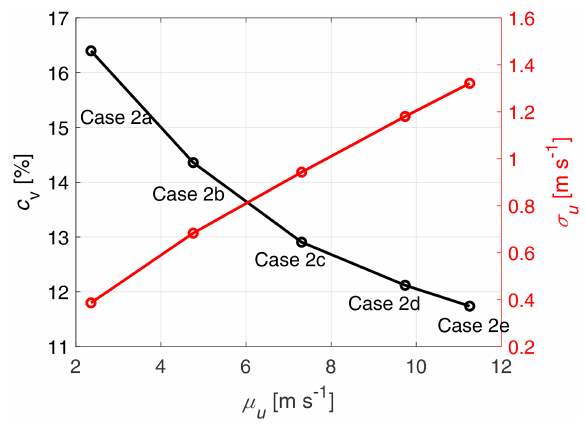
Figure 13. Plot of the standard deviation σ u and coefficient of vari- ation c v as a function of the mean wind speed µ u calculated from the hot-wire time series of each of the five cases 2a–2e.